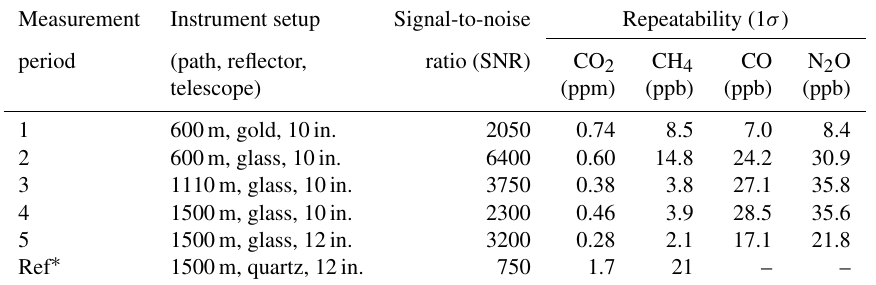
Table 3. Summary of the measurement performance during the field deployment at each path length and over changes in instrument setup. The numbered measurement periods and setups correspond to those in Table 2. Measurement Instrument setup